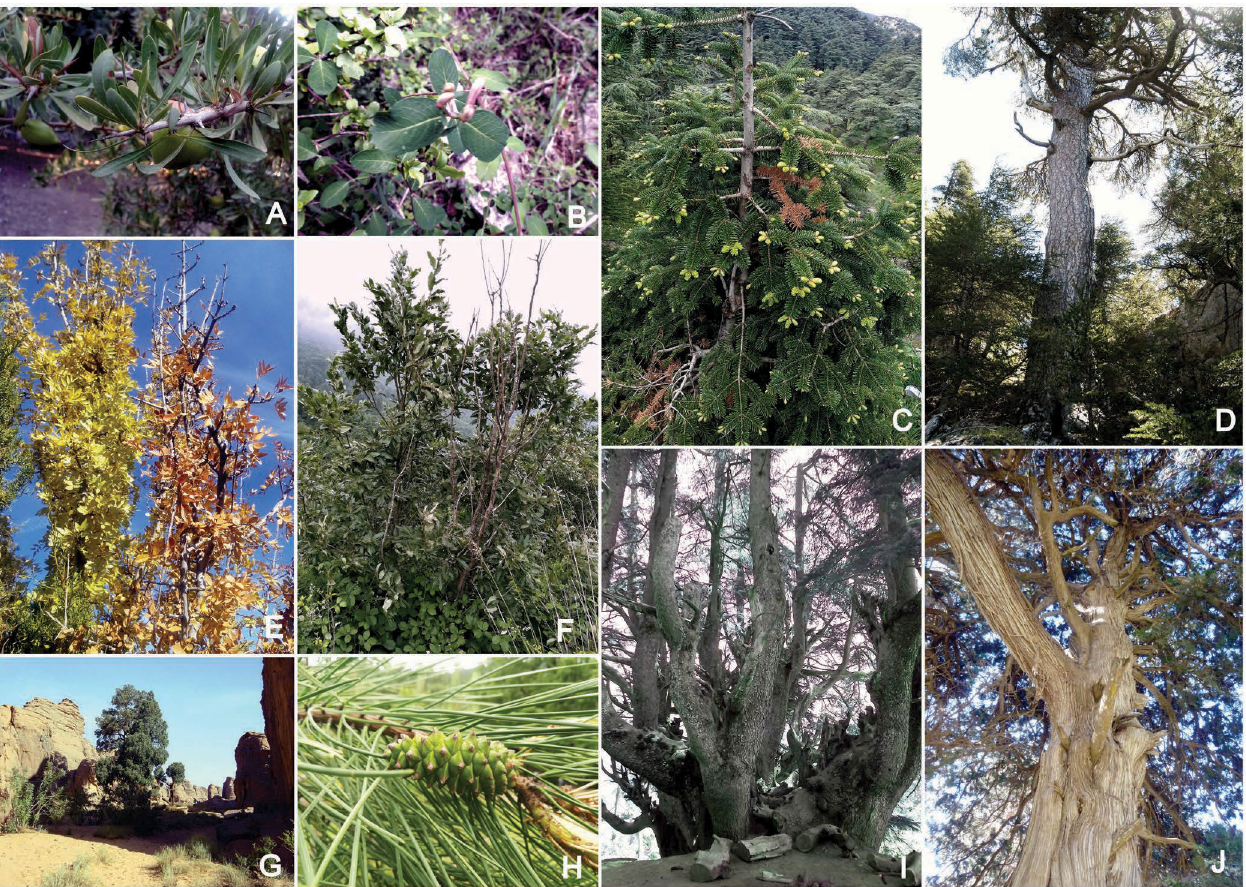
Figure 2 – Photographs of a few endemic and subendemic tree species in Algeria. A . Argania spinosa , introduced at Chlef, 16 Oct. 2013. B . Lonicera kabylica , Tikjda at Djurdjura National Park, 27 Jan. 2013. C . Abies numidica , introduced in Chréa National Park, 8 May